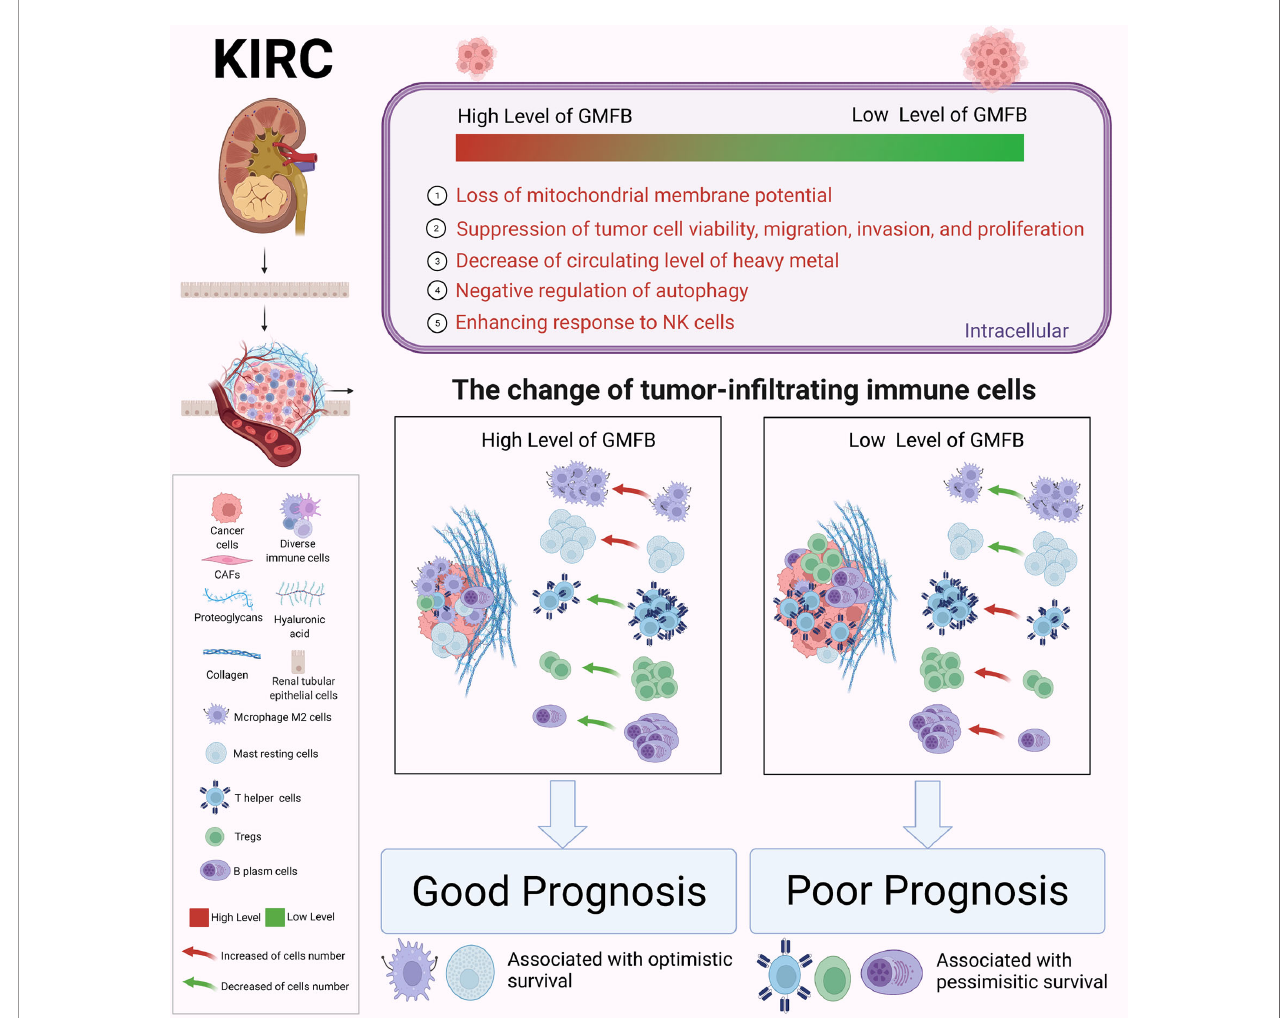
FIGURE 10 | Schematic molecular mechanism of GMFB in the development of kidney renal clear cell carcinoma (KIRC). Created with